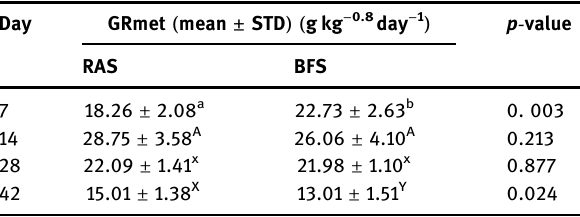
Table 4 : Metabolic growth rate ( mean ± standard deviation ) of Tilapia larvae cultured in recirculating aquaculture system ( RAS ) and